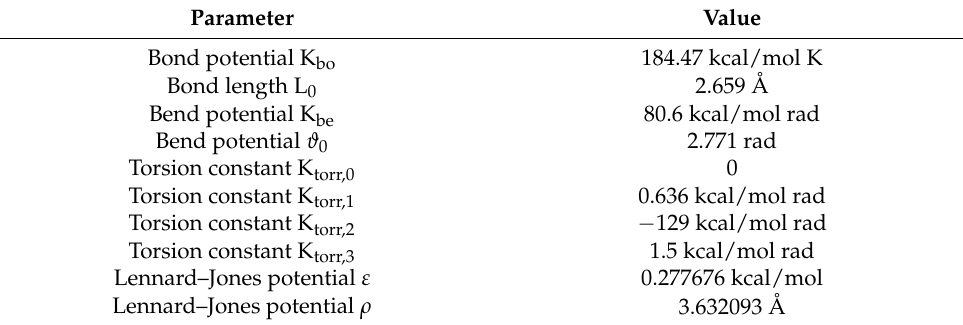
Table 4. Overview of the most important Monte-Carlo simulation parameters